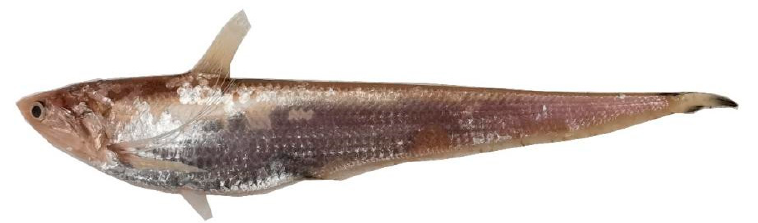
Figure 1. Anadromous Coilia nasus .